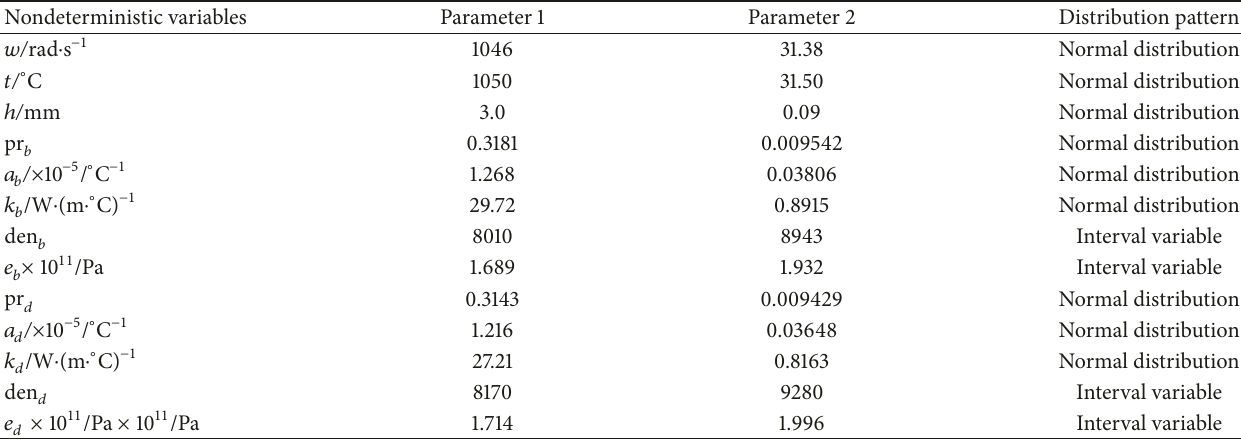
Table 3: Distribution of nondeterministic variables of mistuned